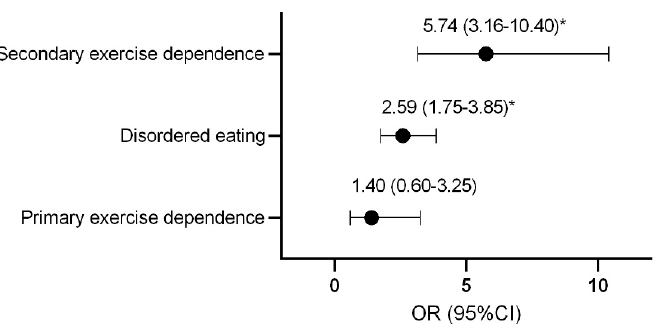
Figure 2. Odds ratio and confidence interval of ( a ) previous menstrual dysfunction ( b ) current menstrual dysfunction and ( c ) suppression of morning erections with disordered eating and exercise dependence status. * p < 0.05. OR, odds ratio; CI, confidence interval. 3.3.3. Gastrointestinal Symptoms For both females (Figure 3a) and males (Figure 3b), athletes with secondary exer- cise dependence and disordered eating athletes were at an increased risk of reporting gastrointestinal symptoms at an increased frequency compared to controls.